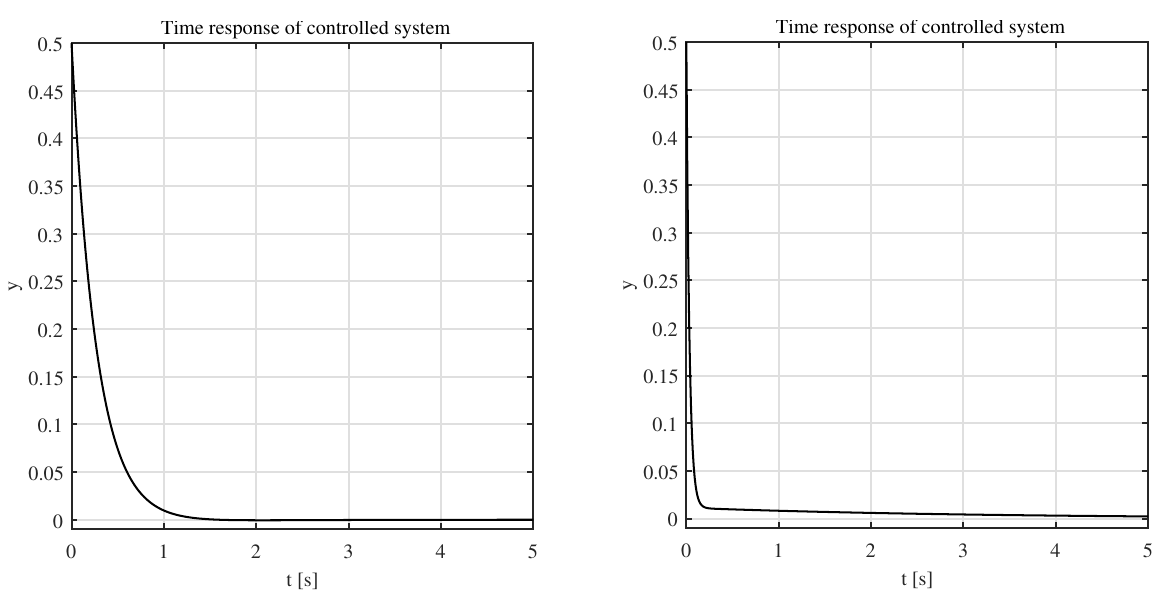
Figure 4: Time response of the controlled output variable.